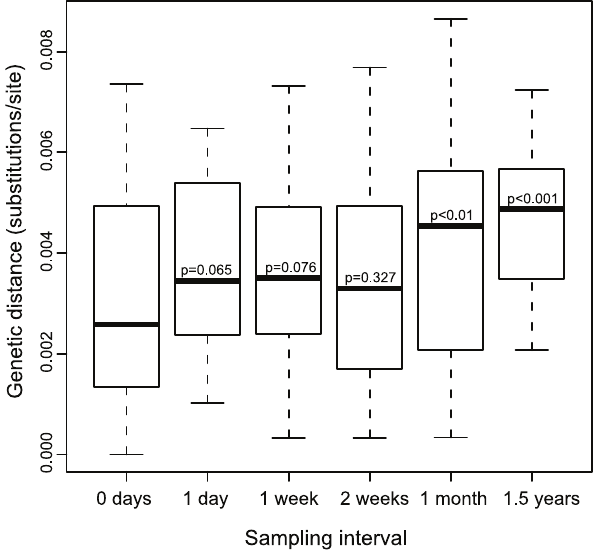
Figure 4. Genetic divergence in subpopulation s6. Mean pairwise distances were calculated between sequences sampled with different time intervals. At an interval of one month or more, the genetic distances were significantly greater than the intra-sample diversity (0 days interval) (p , 0.01, Wilcoxon rank sum test). Sampling intervals of 1–2 days and 3–4 weeks were estimated together and are named 1 day, and 1 month, respectively. doi:10.1371/journal.pone.0021747.g004 PLoS ONE |